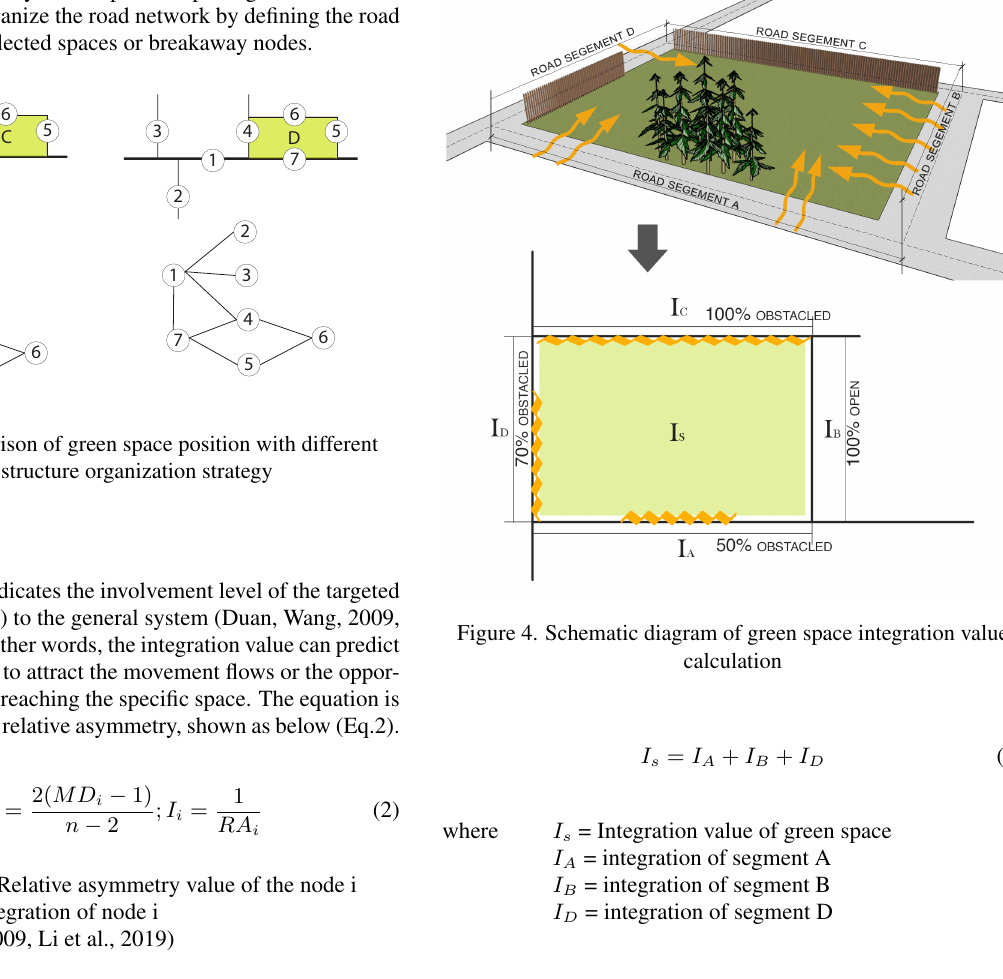
Figure 2. Depth of targeted green space comparison 3, we compare the depth value of the green space C and D with the different algorithm strategies. For the green space C, the entire main road is set as only one node (Node 1) for the depth analysis. For the green space D, the road segment of the main road adjacent to the green space is divided away from the main road as an independent node (Node 7). Although green space C and D have the same location within the same road network, when we define the space nodes in different ways, the spatial network structure and the positions of the green space in the networks are different. The spatial network structure compar- ison (see Figure 3) illustrates that the spatial structure strategy for green space D would be more accurate. This is because the green space don’t have direct connection to the Road 2 and 3.